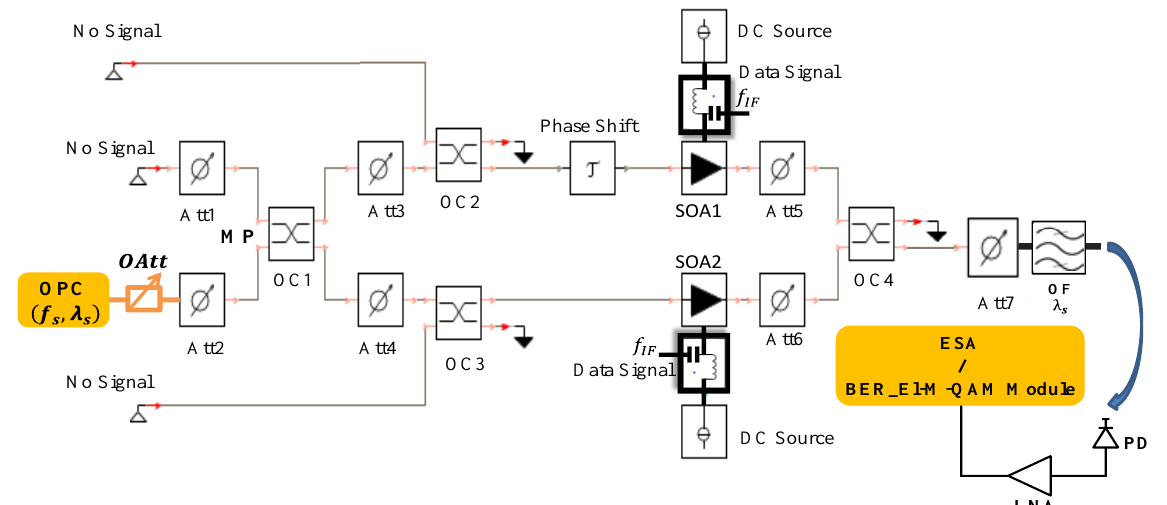
Figure 2. Mixing setup used in a VPI simulator counted on the modulation of the differential mode. ESA: Electrical Spectrum Analyzer, Att: Attenuator, OF: Optical Filter, LNA: Low-Noise Amplifier, BER: Bit Error Rate, QAM: Quadrature Amplitude Modulation, PD: Photodiode, and OPC: Optical Pulse